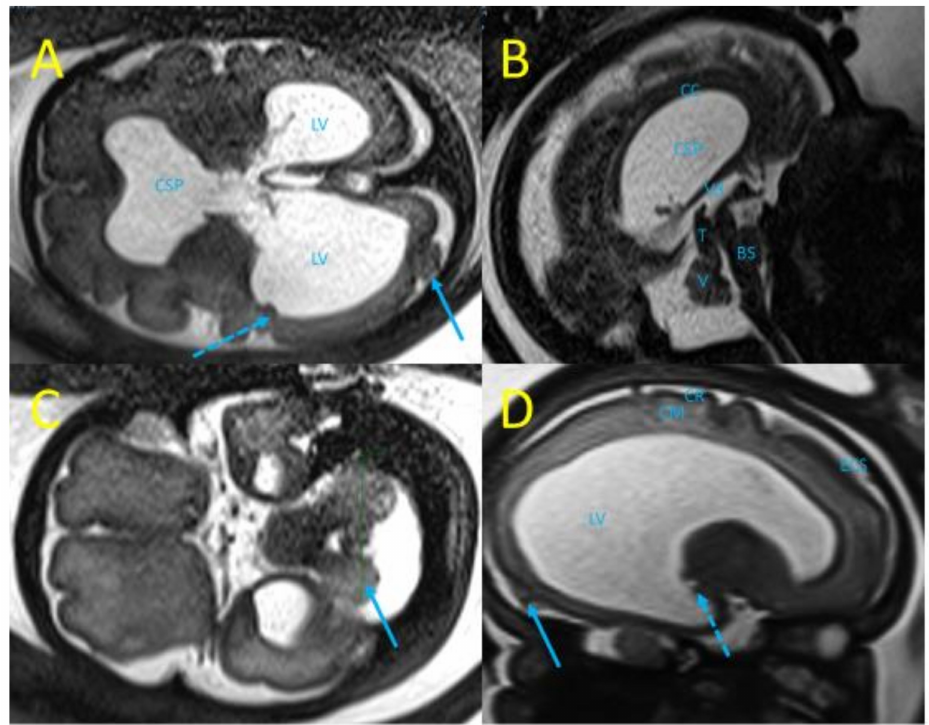
Figure 3. Fetal MRI at 29 wg (T2 weighted sequences). ( A ) Trans-ventricular axial plane with severe bilateral ventriculomegaly, lateral ventricles (LV) at 27 mm and 21 mm, disruption of the cavum septi pellucidi (CSP), subependymal nodules (dot arrow), and occipital polymicrogyria (arrow). ( B ) Mid-sagittal plane with laminated corpus callosum (CC), dilated third ventricle (3 V), thick tectum (T), hypoplasia of the vermis (V), and brainstem (BS). ( C ) Trans-cerebellar axial plane with dysplasia of a cerebellar hemisphere (blue arrow). ( D ) Para-sagittal plane with enlarged LV, subependymal nodules (dot arrow), atrophy of the cortical mantle (CM), irregular cortical ribbon (CR), suggestive of occipital polymicrogyria